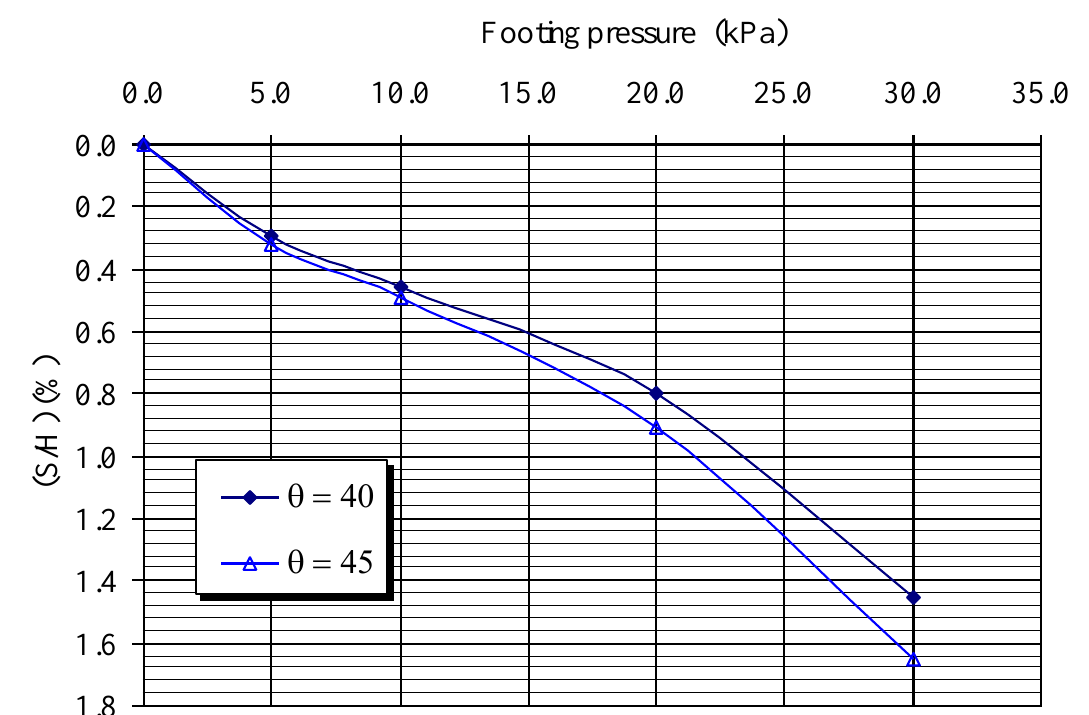
Figure 13. Influence of slope inclination on the settlement of the footing.